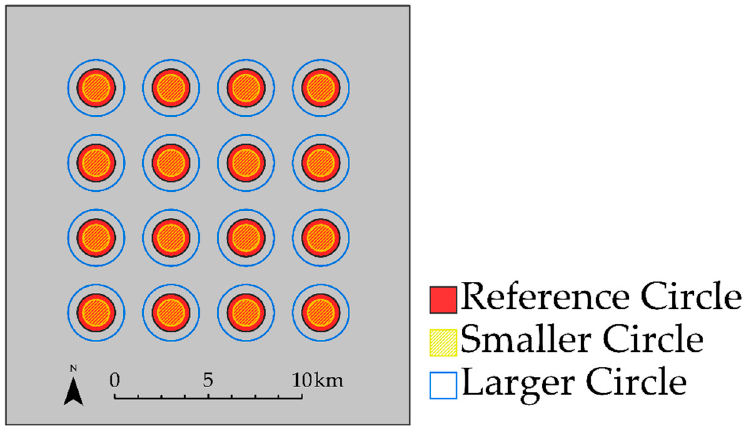
Figure 5. Synthetic data used to explore the impact of over- and under-prediction of feature area.